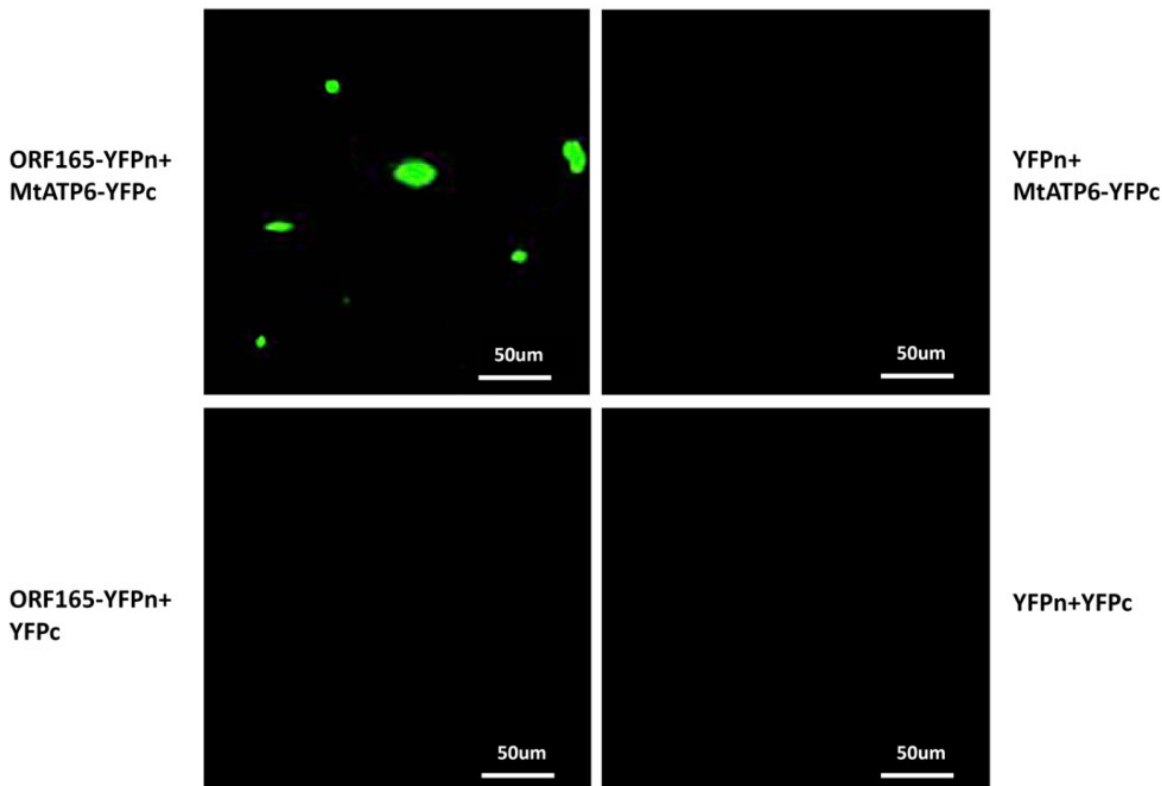
Figure 6 ‒ Bimolecular fluorescence complementation (BiFC) assay for in vivo interaction of orf165 with MtATP6. YFP fluorescence was observed when ORF165:YFPn was co-expressed with MtATP6:YFPc. No YFP fluorescence was detected in control infiltration of ORF165:YFPn with YFPc, YFPn with MtATP6:YFPc, and YFPn with